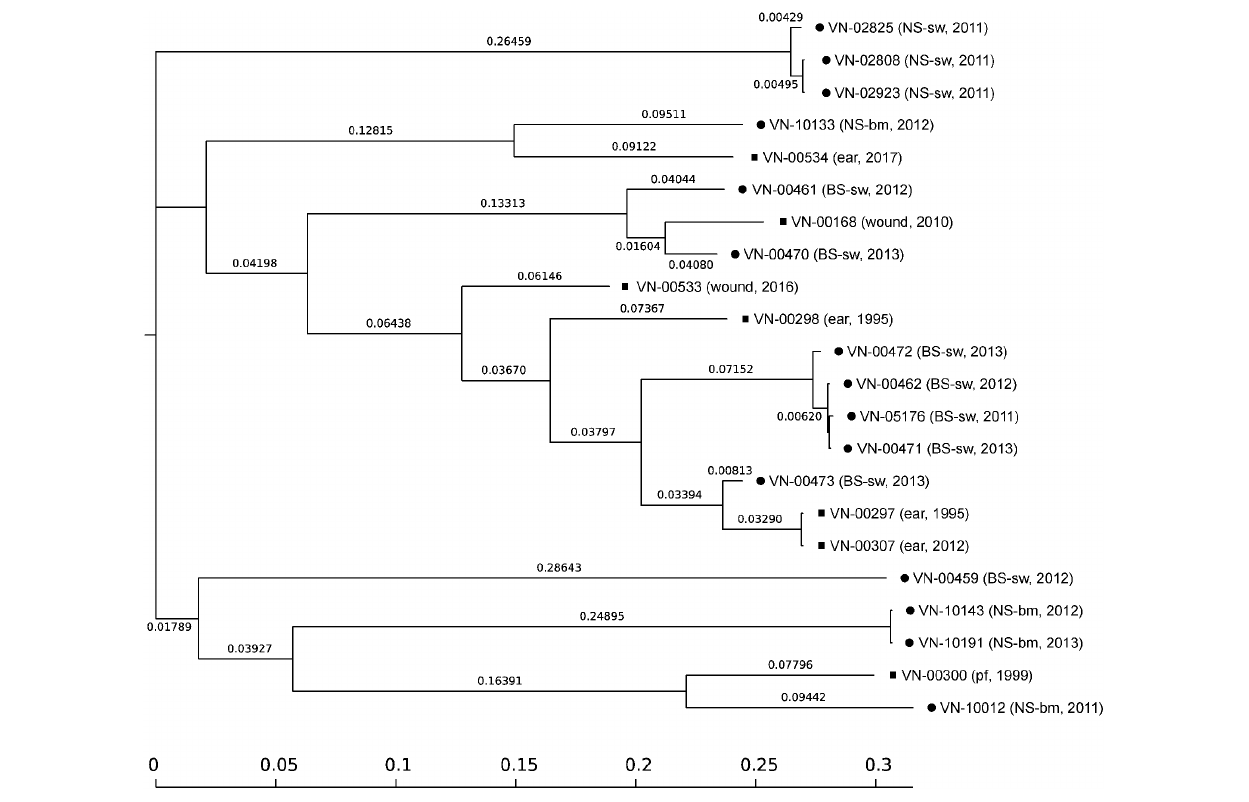
FIGURE 3 | SNP-based phylogeny tree of Vibrio cholerae non-O1, non-O139 isolates from German coastal waters ( • ) and from German clinical samples ( (cid:4) ). SNP tree was conducted using CSI Phylogeny 1.4 under default settings and the exclusion of heterozygous SNPs. Single nucleotide polymorphisms (SNPs) were called by mapping to the V. cholerae VN-00533 genome as reference (MWZM00000000). Scale bar represents the number of nucleotide substitutions per site and numbers indicate branch length. Basic information about the sample type and the year of isolation are given after the strain identifier: North Sea/seawater (NS-sw), North Sea/bivalve mollusk (NS-bm), Baltic Sea/seawater (BS-sw), and peritoneal fluid